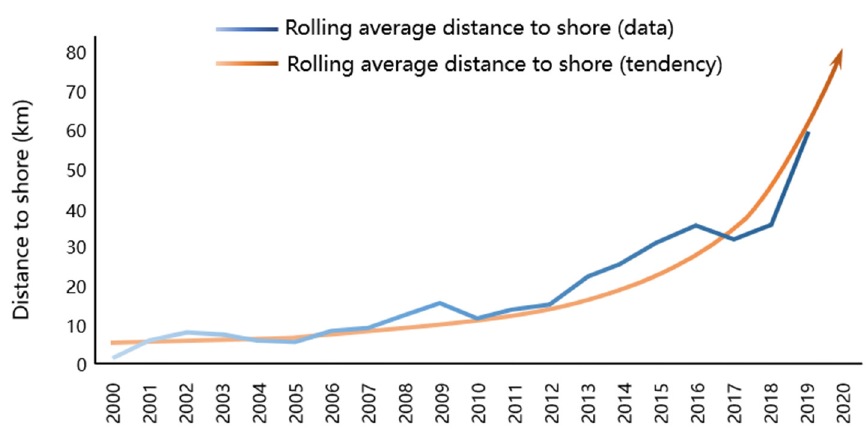
Figure 4. Average distance to shore of offshore wind turbine (OWTs) in Europe (modified from [66]).